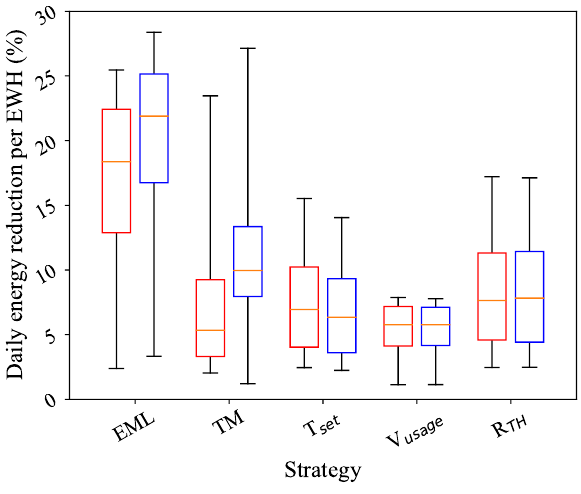
Figure 4. Box plot showing the distribution of the daily reduction in energy consumed (as a percent- age) for summer (red) and winter (blue) by each EWH compared to that produced by the baseline energy consumption for T set (set to 60 °C), V usage (10% reduction), and R TH (thermal blankets and pipe